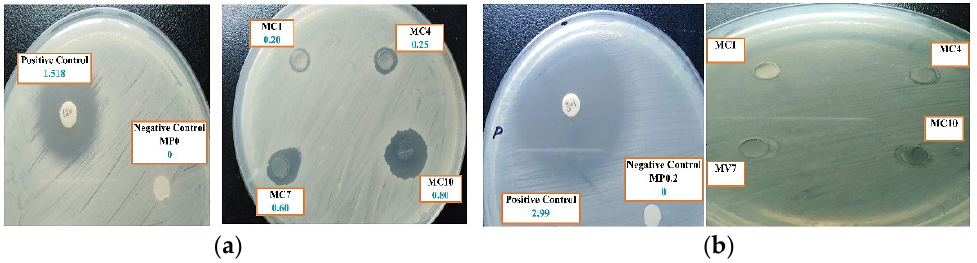
Figure 14. Images of surfaces of agar diffusion studies of the fabricated membranes to ( a ) S. aureus and ( b ) E. coli inoculums, respectively.